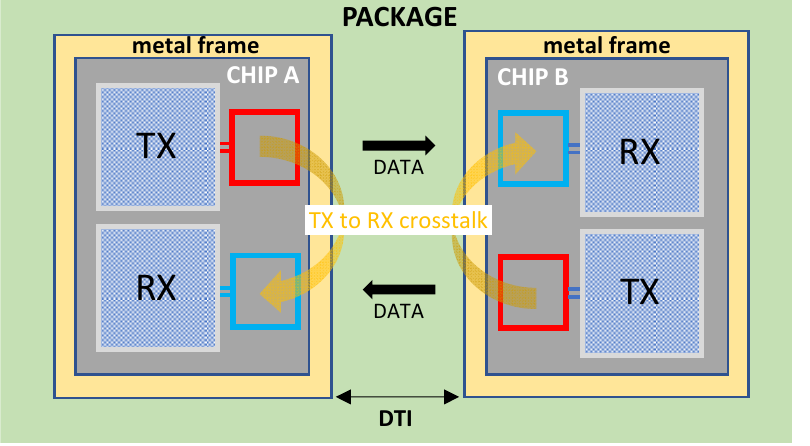
Figure 5. Representation of bidirectional full-duplex galvanic isolator based on RF